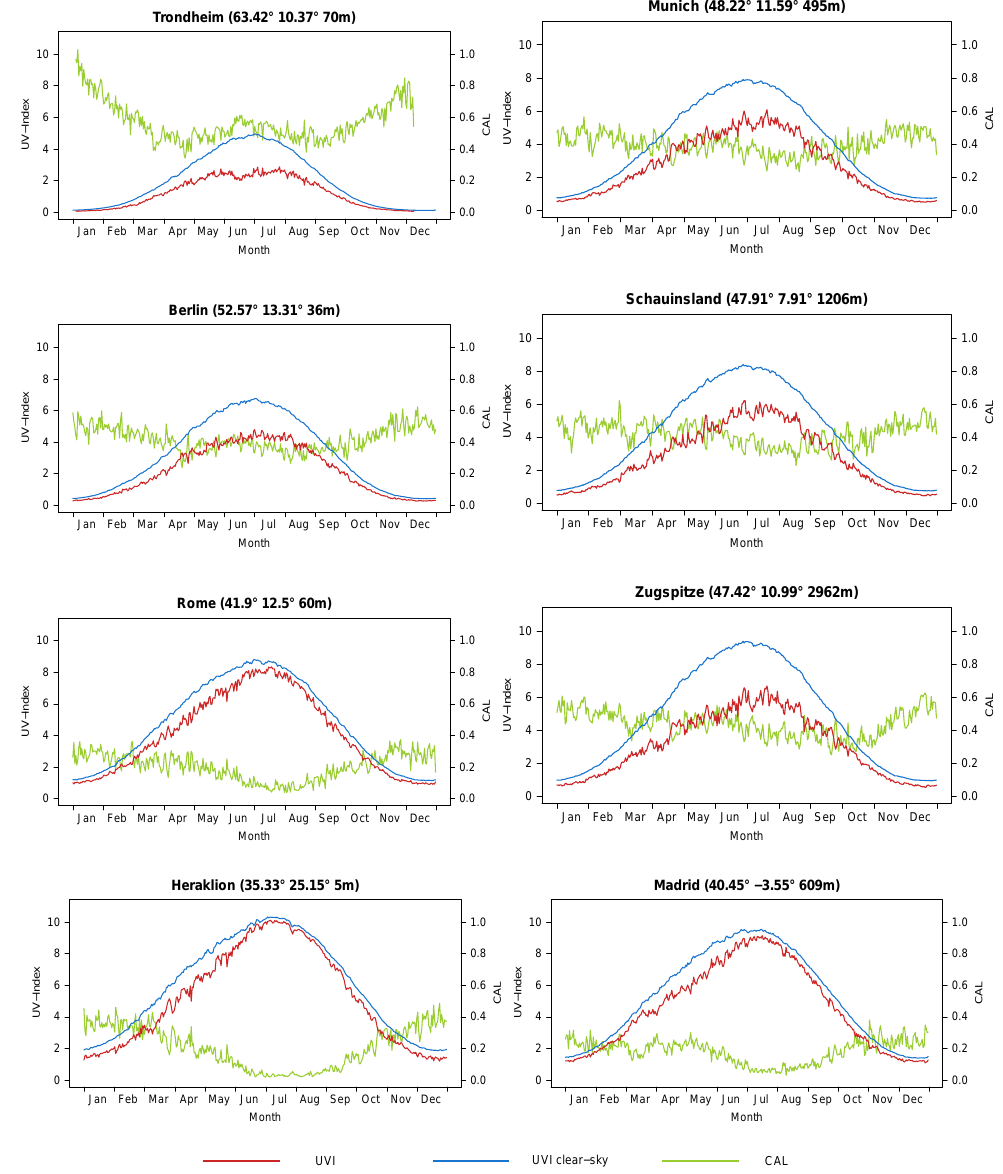
Figure 5. Mean course of the year for noontime UVI, noontime UVI clear − sky and cloud albedo (CAL) over the time period 1983–2015 for each location based on satellite